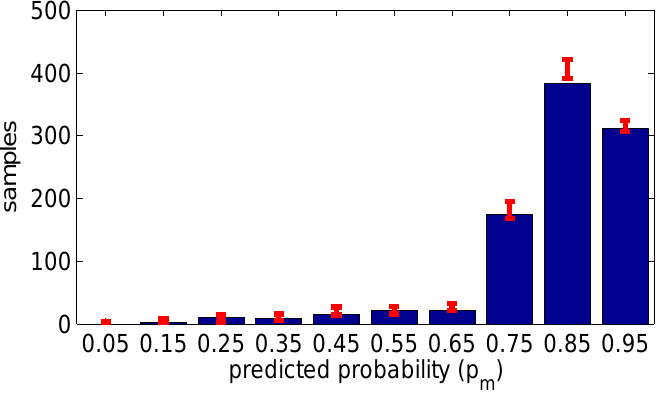
Figure 10. The number of samples (yes answers) at each bin centered at p from Binomial distribution (activities).